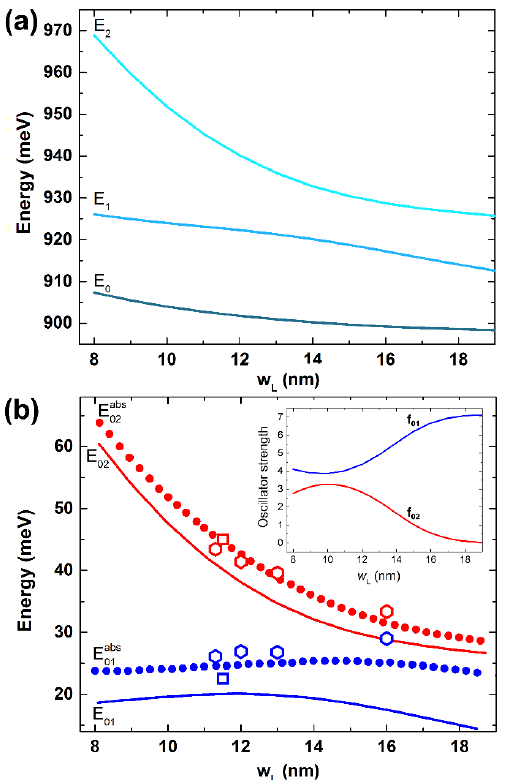
Figure 5. ( a ) Calculated energies of the fundamental ( E 0 ), first excited ( E 1 ) and second excited ( E 2 ) electron states for ACQW structures with a narrow well of 5 nm and a Si 0.13 Ge 0.87 tunnel barrier b t = 2.3 nm as a function of the wide well width w L . ( b ) Corresponding energies of the E 01 and E 02 ISB transitions (continuous lines) and optical resonances (full dots). In the simulations, the sheet carrier density is n 2 D = 7 × 10 11 cm − 2 . The hexagonal (square) empty markers represent the experimental resonance energies obtained from FTIR spectra for samples with n 2 D (cid:27) 7 × 10 11 cm − 2 ( n 2 D = 1.0 × 10 11 cm − 2 ). E abs ( E abs ) is shown in blue (red) color. In the inset, the calculated oscillator 02 01 strength f 01 ( f 02 ) for the 0- > 1 (0- > 2) transition is displayed as a function of w L for the same design parameters as in the main